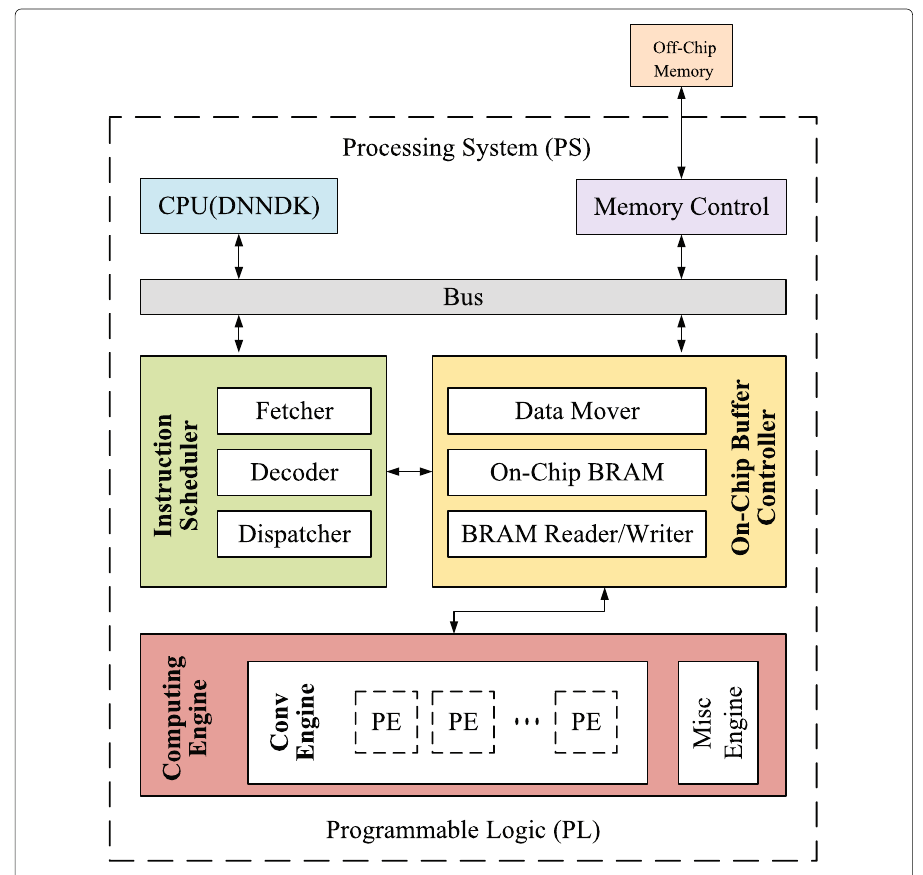
Fig. 9 Hardware architecture of software and hardware co-design